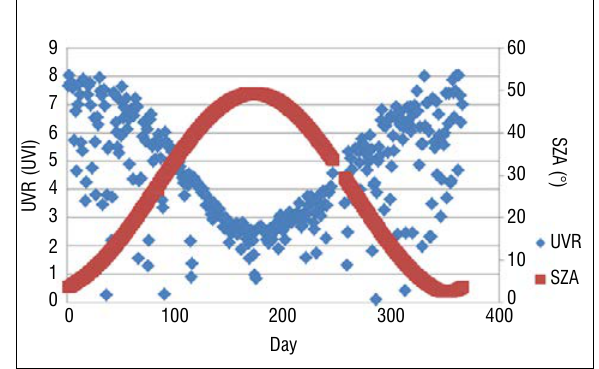
Figure 4: Distribution of solar ultraviolet radiation (UVR) and solar zenith angle (SZA) over Pretoria for the year 2012. Figure 5 shows that ozone does not vary significantly during the year. This is also reflected in the results of the regression analysis. Research has shown that sites at lower latitudes have a small annual variation in total column ozone, while sites at high latitudes have a large annual variation in total column ozone. 32 In Oslo, Norway, which is at latitude 59° 57’N, ranges of over 250 DU between the highest and the lowest measured ozone values have been measured. 32 In the year 2012, the range between the highest and the lowest measured total column ozone values over Pretoria (which is at latitude 25° 45’S) was 75.832 DU, thus showing relatively small annual variation. That being said, the relationship between solar UVR and total column ozone for spring was the strongest of all the seasons; this finding is to be expected as relatively higher values of ozone over South Africa are expected to occur during spring.